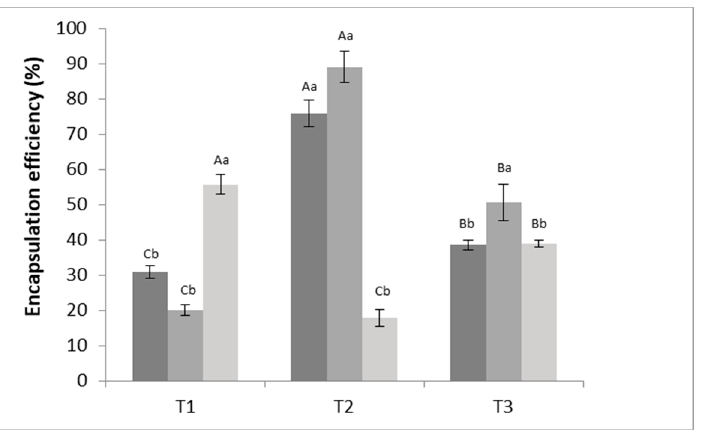
Figure 2. Encapsulation efficiency (%) of phenolic compounds incorporated in alginate particles produced using different alginate and CaCl 2 concentrations. T1 = 2% sodium alginate; T2 = 1.5% sodium alginate; T3 = 1% of sodium alginate. Different colors of the bars represent different calcium chloride concentrations ( —1 mol·L − 1 , —0.5 mol·L − 1 , —0.25 mol·L − 1 ). Averages followed by uppercase letters are related to significant differences among tests T1, T2, and T3, while lowercase letters are correlated to significant differences according to molar concentrations within the same test ( p ≤